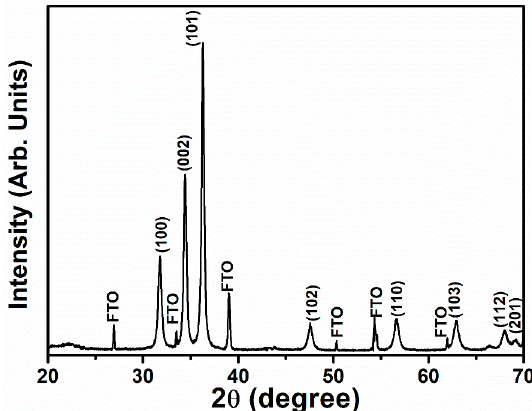
Figure 1. Typical XRD pattern of flower-shaped ZnO nanostructures directly grown on fluorine-doped tin oxide (FTO) substrate.